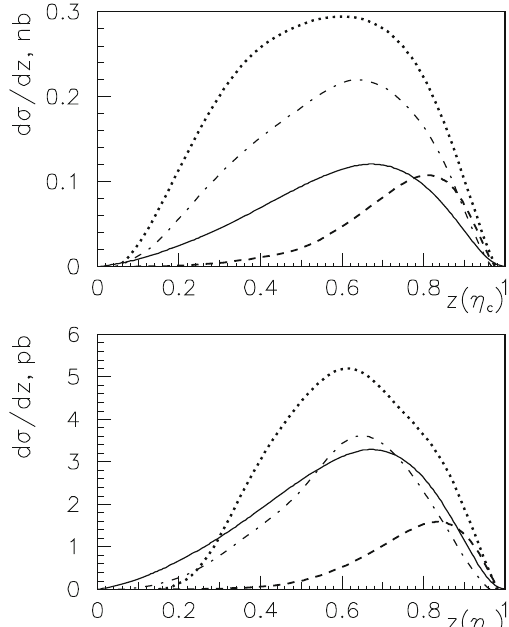
Fig. 4 The process g + g → η c + c + ¯ c ; invariant mass of the η c + c system as seen under the different kinematic constraints. Upper panel: dotted, p η T > 5 GeV, p ∗ 20 GeV; dash-dotted, m ∗ < E ∗ / 3; solid, factorization calculation for > 20 GeV. Lower panel: dotted, p η p ∗ T dashed, p η T > 50 GeV, p ∗ solid, factorization calculation for p ∗